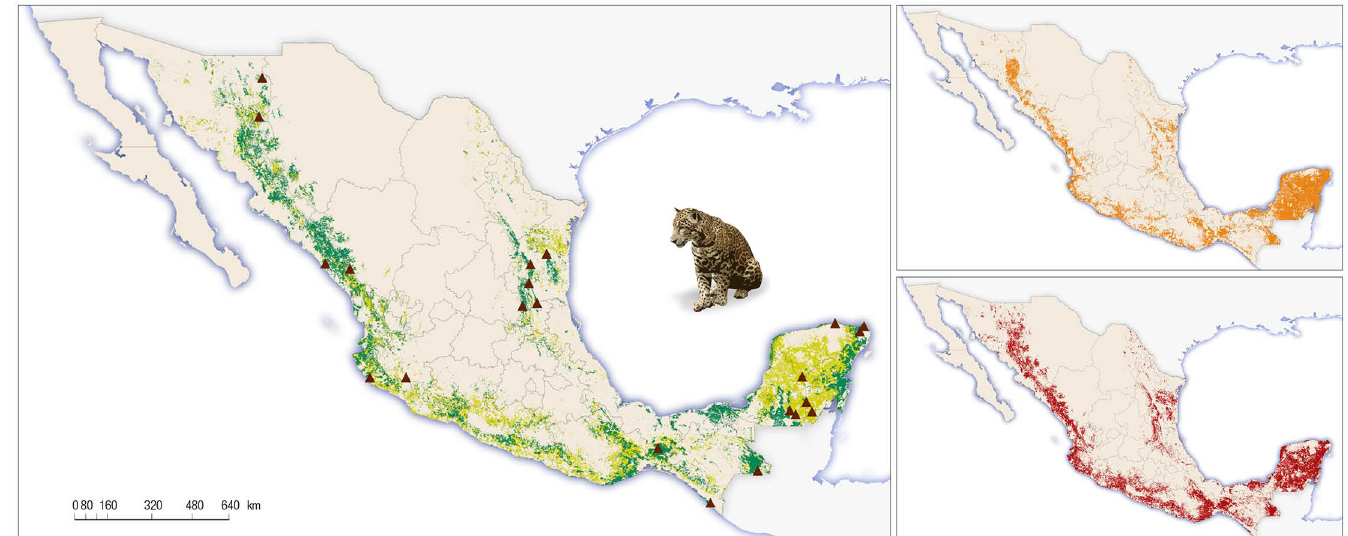
Fig 4. Vegetation types and their broad-scale distribution for 2018 and location study sites from CENJAGUAR within jaguar (a). Time-calibrated species distribution models for 2010 (b) and for 2018 (c) in Mexico.